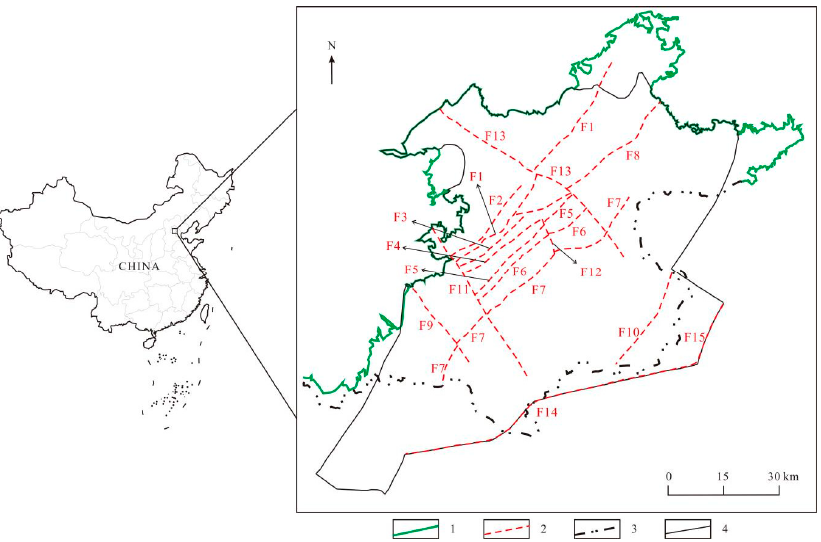
Figure 1. Map of the Beijing plain area, showing boundaries and faults in the study area. 1—Boundary